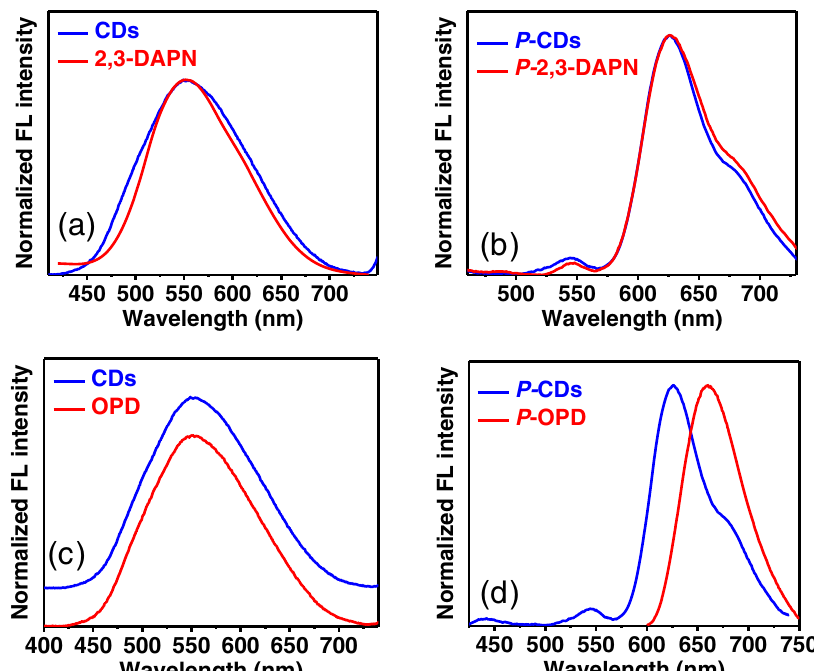
Fig. 6 Comparison of two-photon emission (TPE) between the 2,3-DAPN, OPD, and CDs. a TPE of 2,3-DAPN and CDs without protonation treatment, b TPE of 2,3-DAPN and CDs with protonation treatment; c TPE of OPD and CDs without protonation treatment, d TPE of OPD and CDs with protonation treatment; (P-CDs: CDs with the protonation treatment, P-OPD, and P-2,3-DAPN: OPD and 2,3-DAPN molecular at pH 1